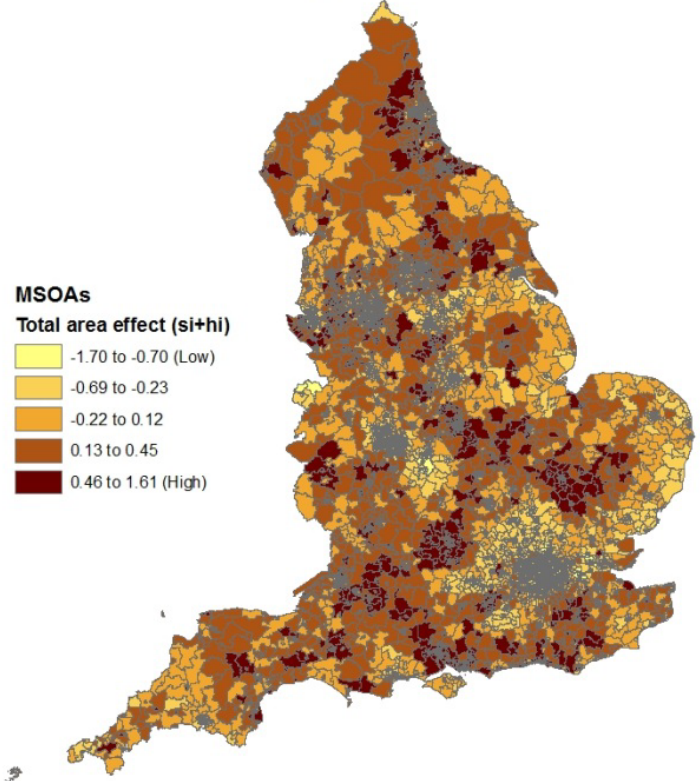
Figure 7. Area effects in self-harm regression after controlling for construct